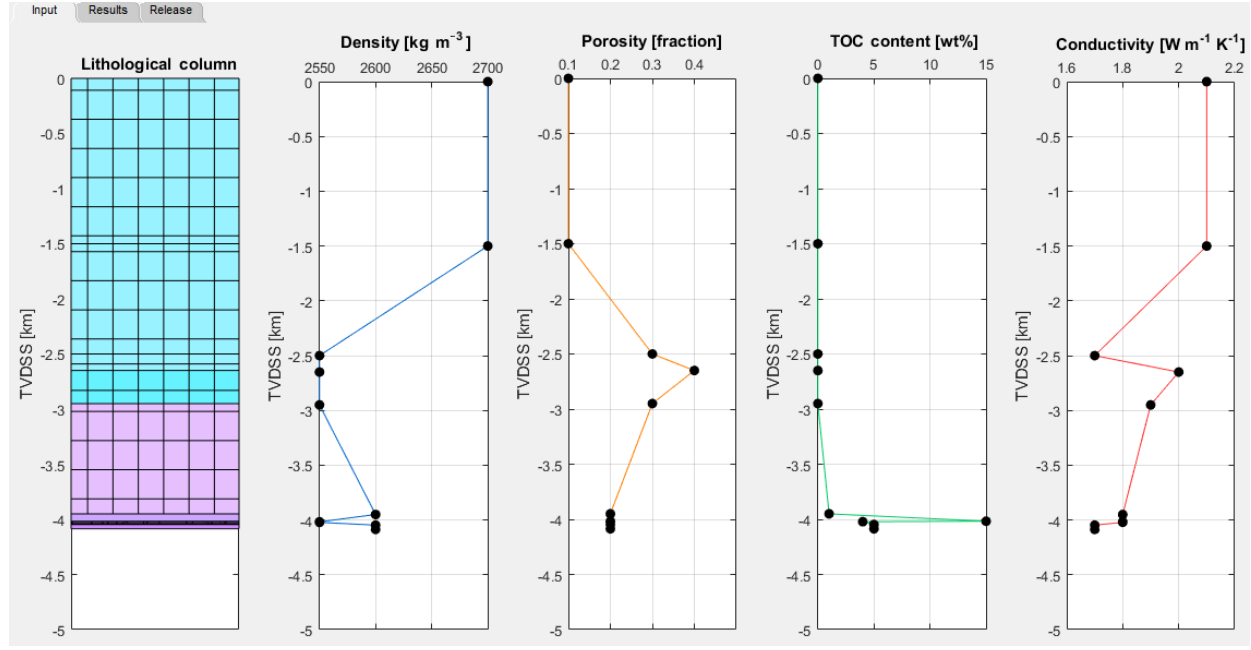
Figure 8. Input tab for KL1/78.